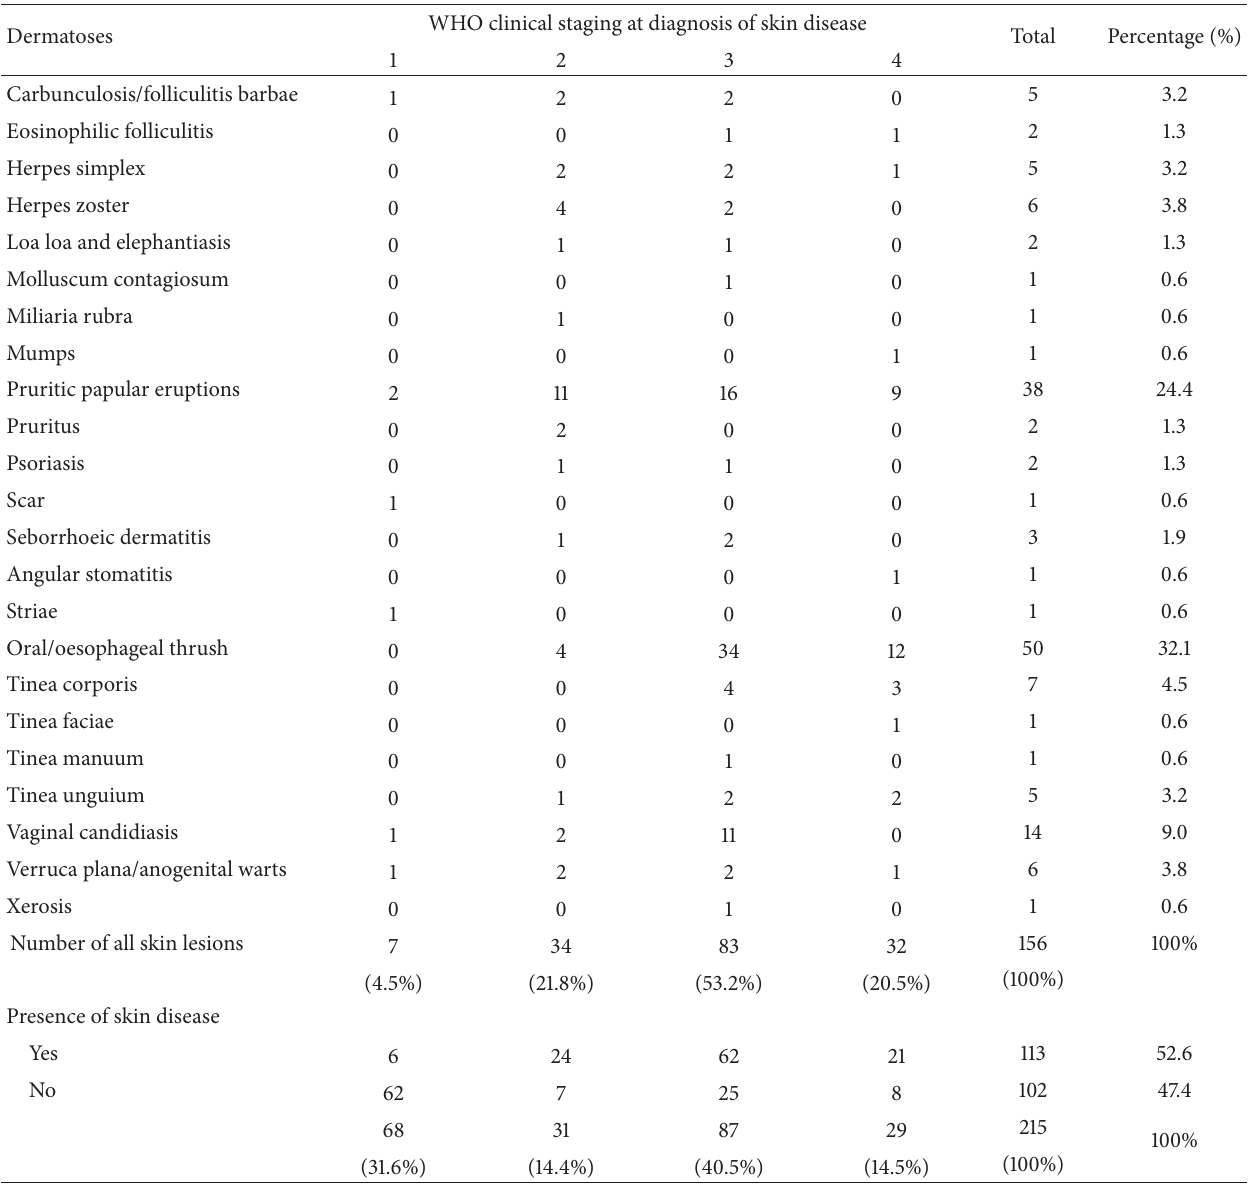
Table 2: Dermatoses occurring in each WHO clinical stage.